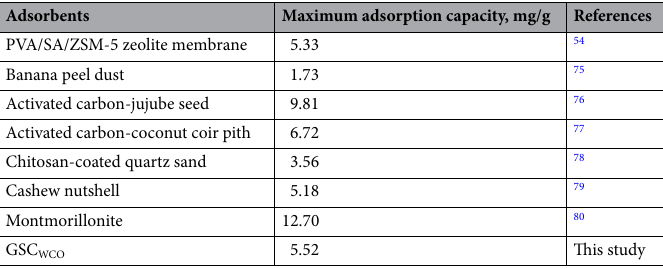
Table 5. Comparison of adsorption capacities of CR by various